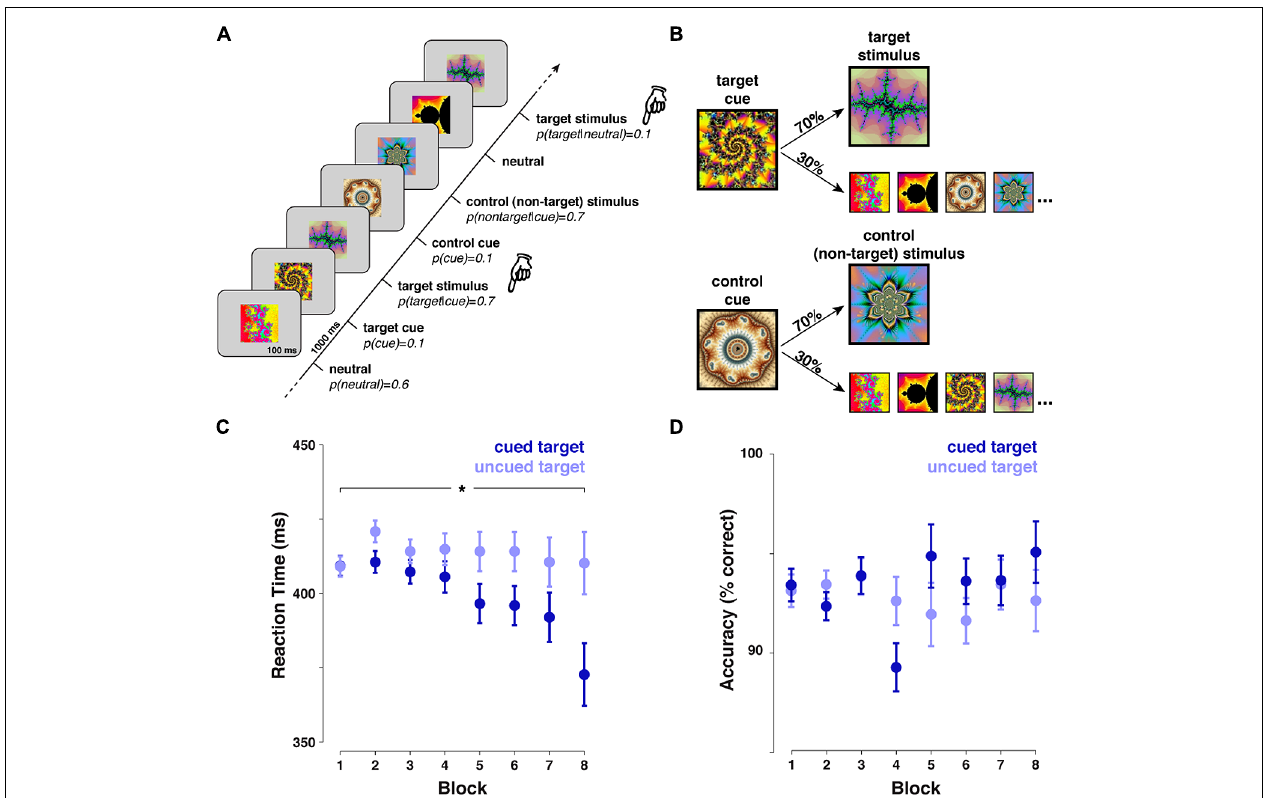
pre-designated target cue (upper) or control cue (lower). These predictive stimuli were followed by the target or control non-target stimulus with 70% validity. On the remaining 30% of trials, stimuli were selected at random from the set of nine remaining stimuli, including the cues and the control or target stimulus. (C) The behavioral response to target stimuli indicated that reaction times were faster for cued targets, relative to uncued targets (main effect: F 1,17 = 4.701, p = 0.045, interaction with block: F 7,119 = 2.621, p = 0.015). (D) Accuracy was high overall, and was not modulated by cues ( p =